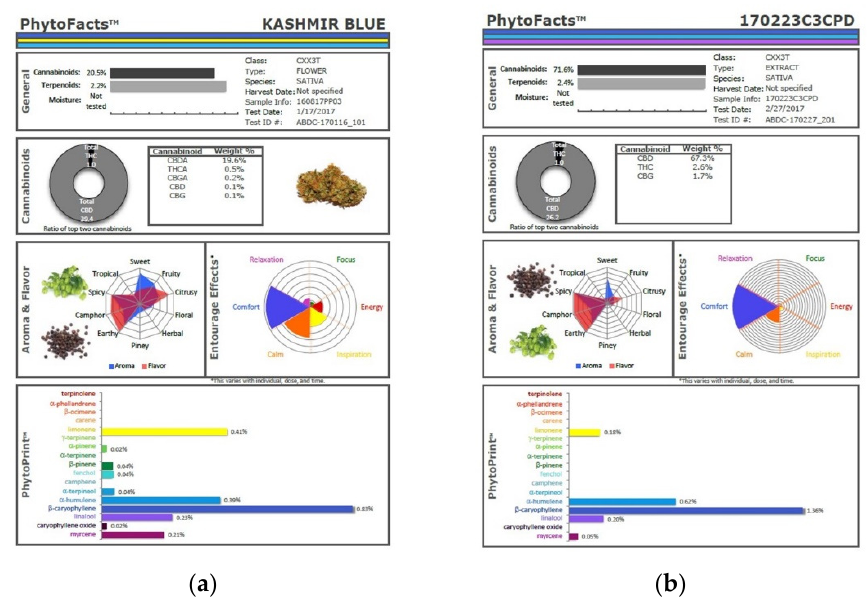
Figure 9. Comparison of cannabinoid and terpenoid profiles from ( a ) Kashmir Blue Type III chemovar flower; ( b ) corresponding cannabinoid and terpenoid profiles after conventional “one pass” supercritical CO 2 extraction.